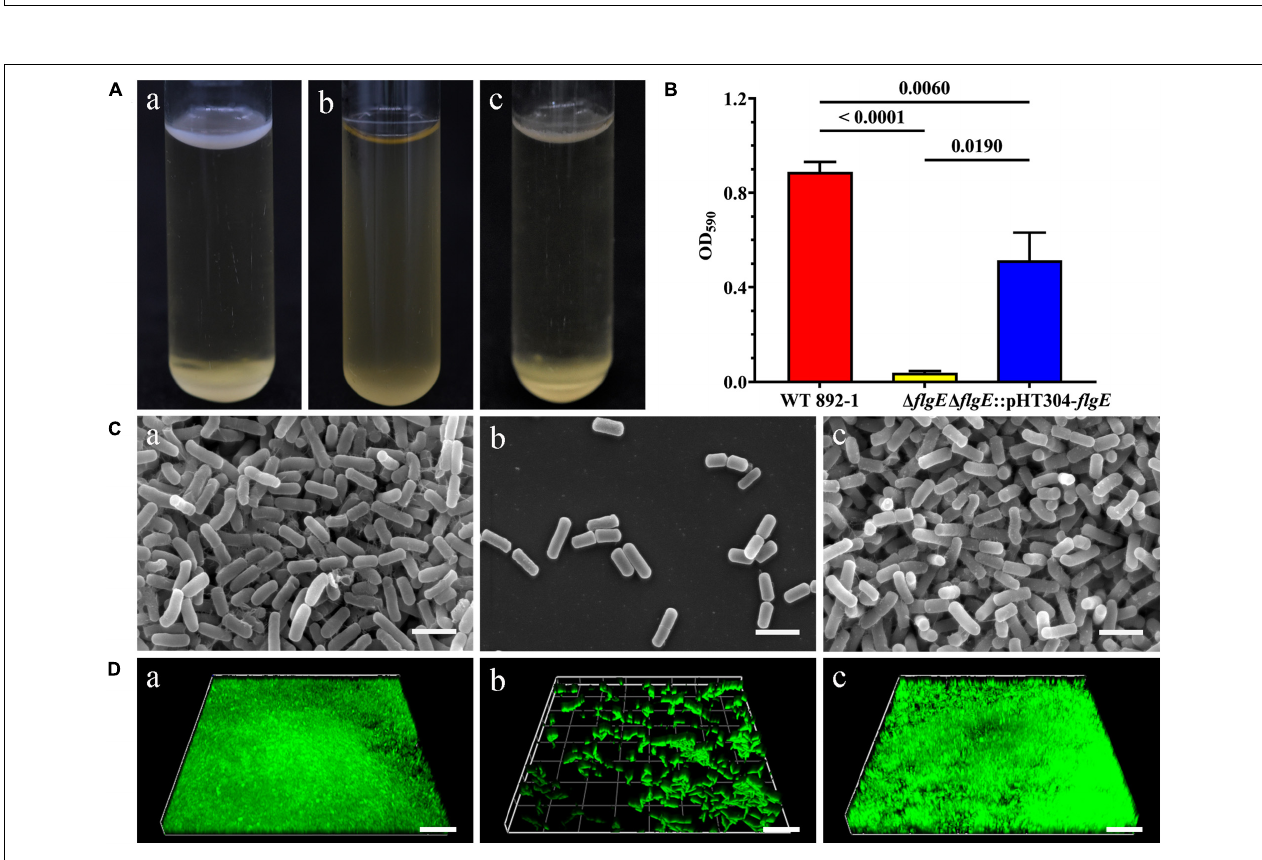
FIGURE 3 | flgE is essential for biofilm formation in emetic B. cereus 892-1. (A) Pellicle formation by wild-type strain (a), (cid:49) flgE (b), and (cid:49) flgE :pHT304- flgE (c). (B) Ring formation by wild-type strain 892-1, (cid:49) flgE , and (cid:49) flgE :pHT304- flgE . P values were calculated using the Student’s t -test. Error bars represent the standard deviation of the mean. (C) SEM images of biofilms formed by (a) wild-type, (b) (cid:49) flgE , and (c) (cid:49) flgE :pHT304- flgE . The scale bars represent three microns. (D) CLSM images of biofilms formed by wild-type (a), (cid:49) flgE (b), and (cid:49) flgE :pHT304- flgE (c). The scale bars represent 30 microns.